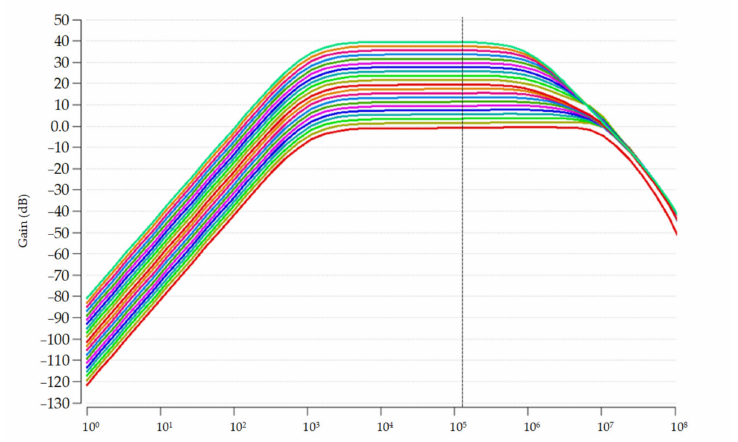
Figure 10. Post-layout simulation results of the provided power gain by AFE.